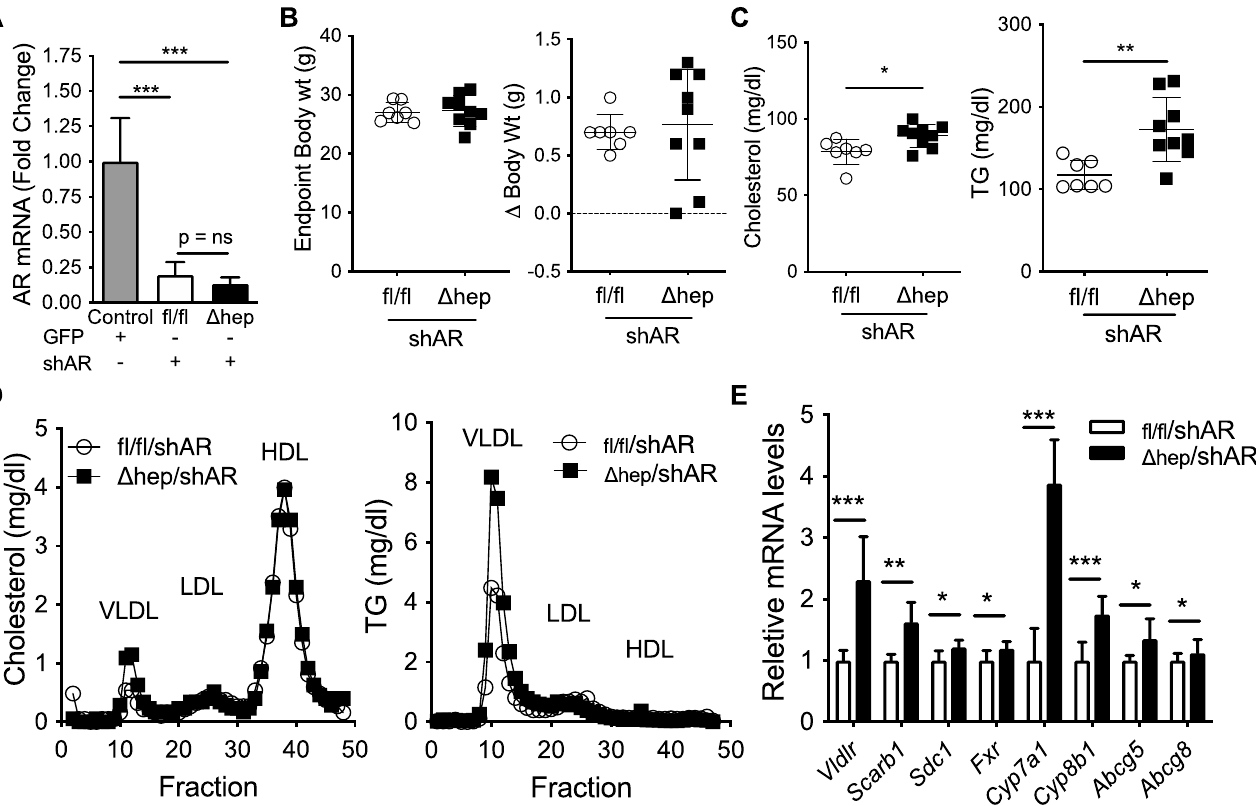
Figure 6. Effect of liver androgen receptor knockdown on hepatic SHP regulation of plasma lipids. Two weeks prior to the study, SHP fl/fl and SHP ∆ hep littermate male mice were treated with 1.8E12GC of adeno-associated virus serotype 8 (AAV8) containing a short-hairpin RNA to knockdown hepatocyte Androgen Receptor (shAR). ( A ) Liver mRNA levels of Ar in SHP fl/fl /shAR and SHP ∆ hep /shAR males. Male C57Bl/6 mice treated with AAV8 containing GFP were used as controls. ( B ) Endpoint body weight and body weight change two weeks after viral treatment in SHP fl/fl /shAR and SHP ∆ hep /shAR males. ( C ) Plasma cholesterol and TG levels. ( D ) Cholesterol and TG content of FPLC separated lipoproteins of pooled plasma. ( E ) Liver mRNA levels. Data shown are mean ± SD ( n = 7~9/group), * p < 0.05, ** p < 0.01, and *** p < 0.001 ( t -test).